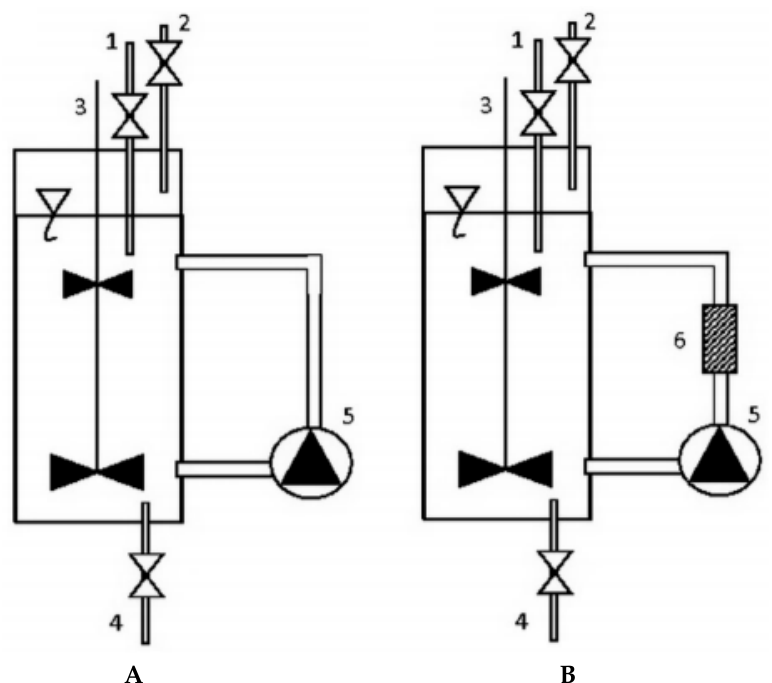
Figure 1. Design of the test site used for the experiments: (A—system without a magnetic